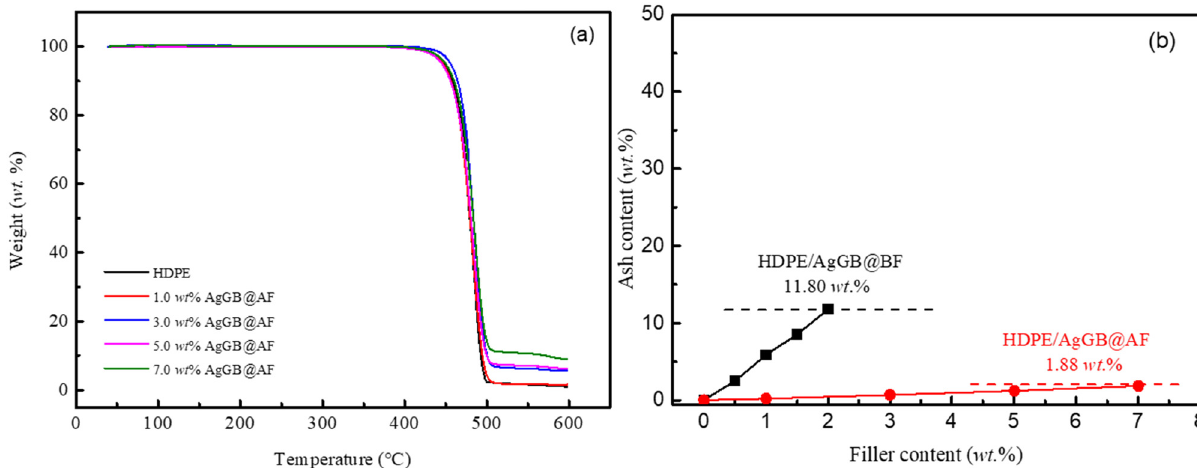
Figure 3: ( a ) TGA curves of HDPE composites, ( b ) ash content curves of HDPE/AgGB@AF and HDPE/AgGB@AF composites.